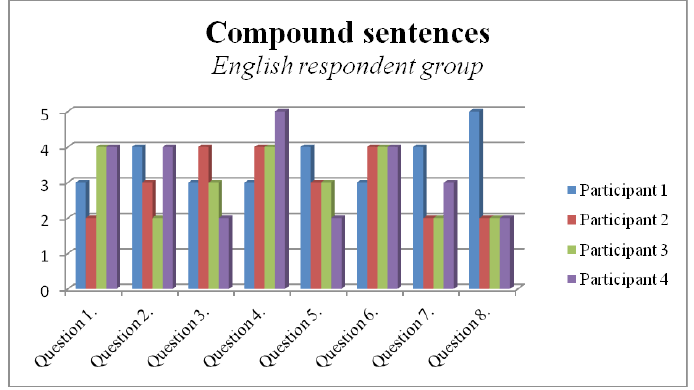
Graphic 10: Compound sentences - English respondent